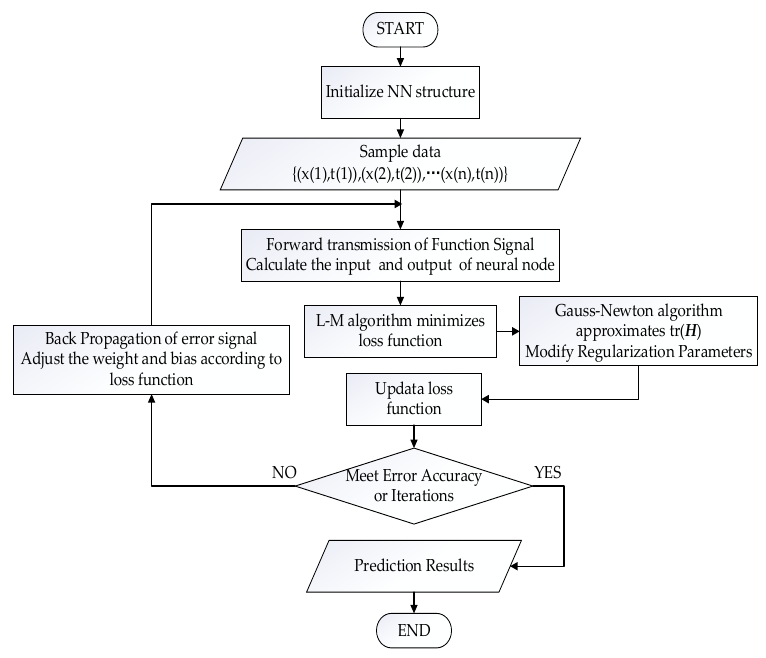
Figure 3. Learning flow chart of BR-BPNN.